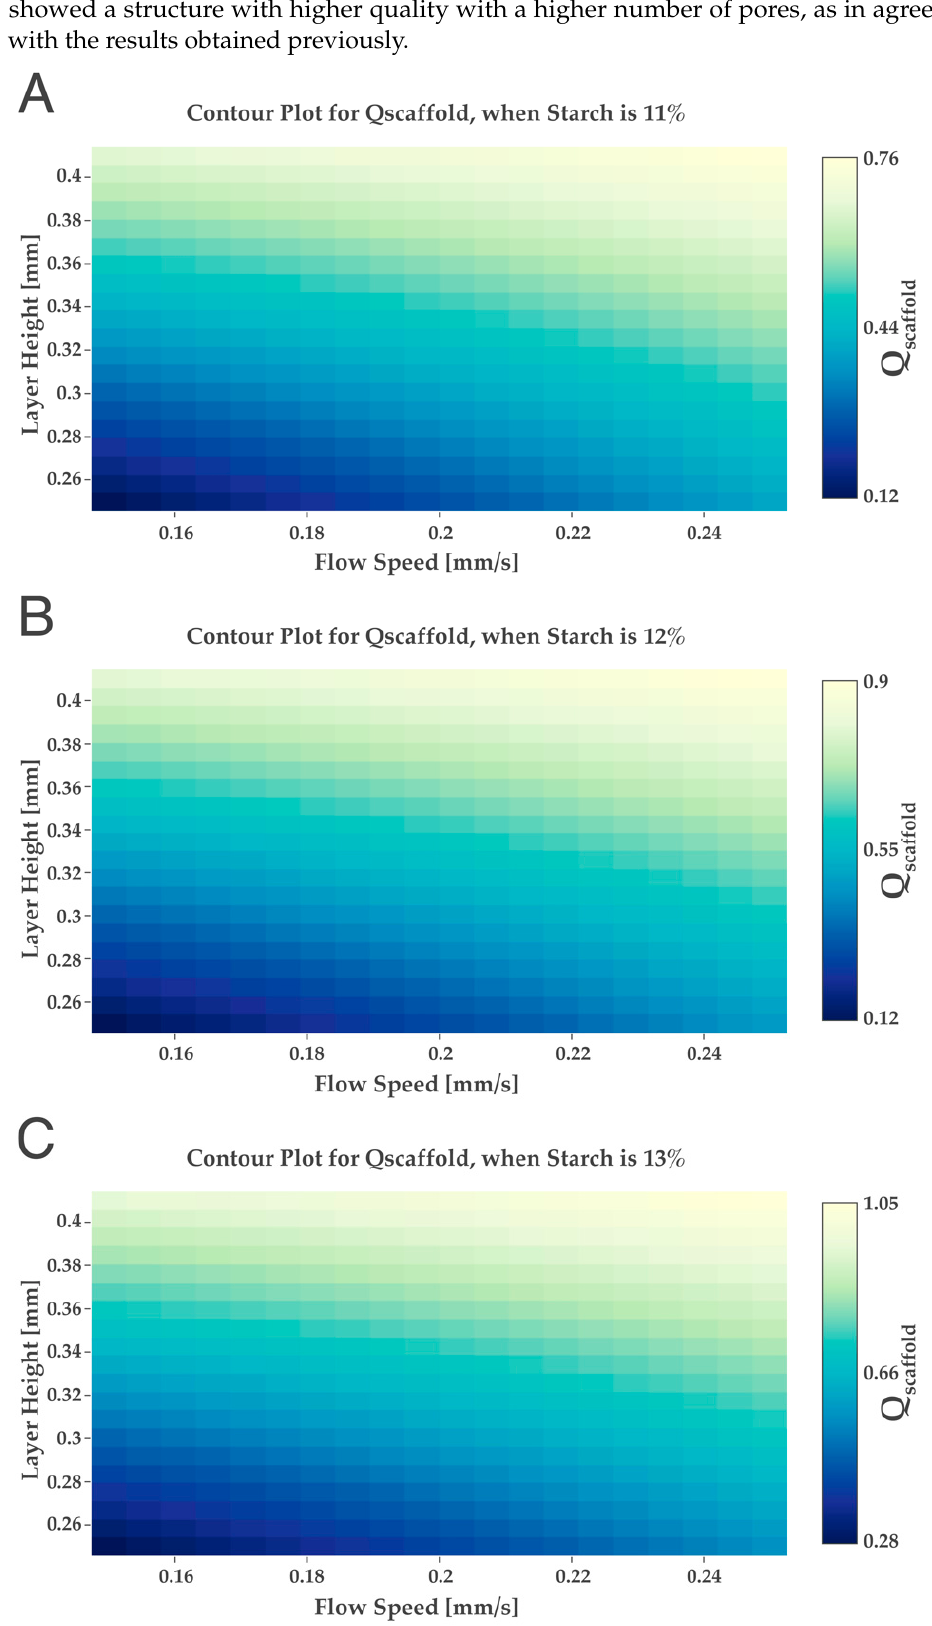
Figure 5. Simulations using different starch percentages ( A ) 11 wt%, ( B ) 12 wt% and ( C ) 13 wt%.